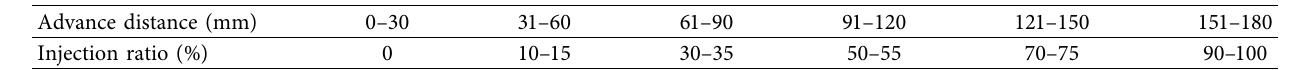
Table 6: Relationship between foam injection ratio and advance distance.